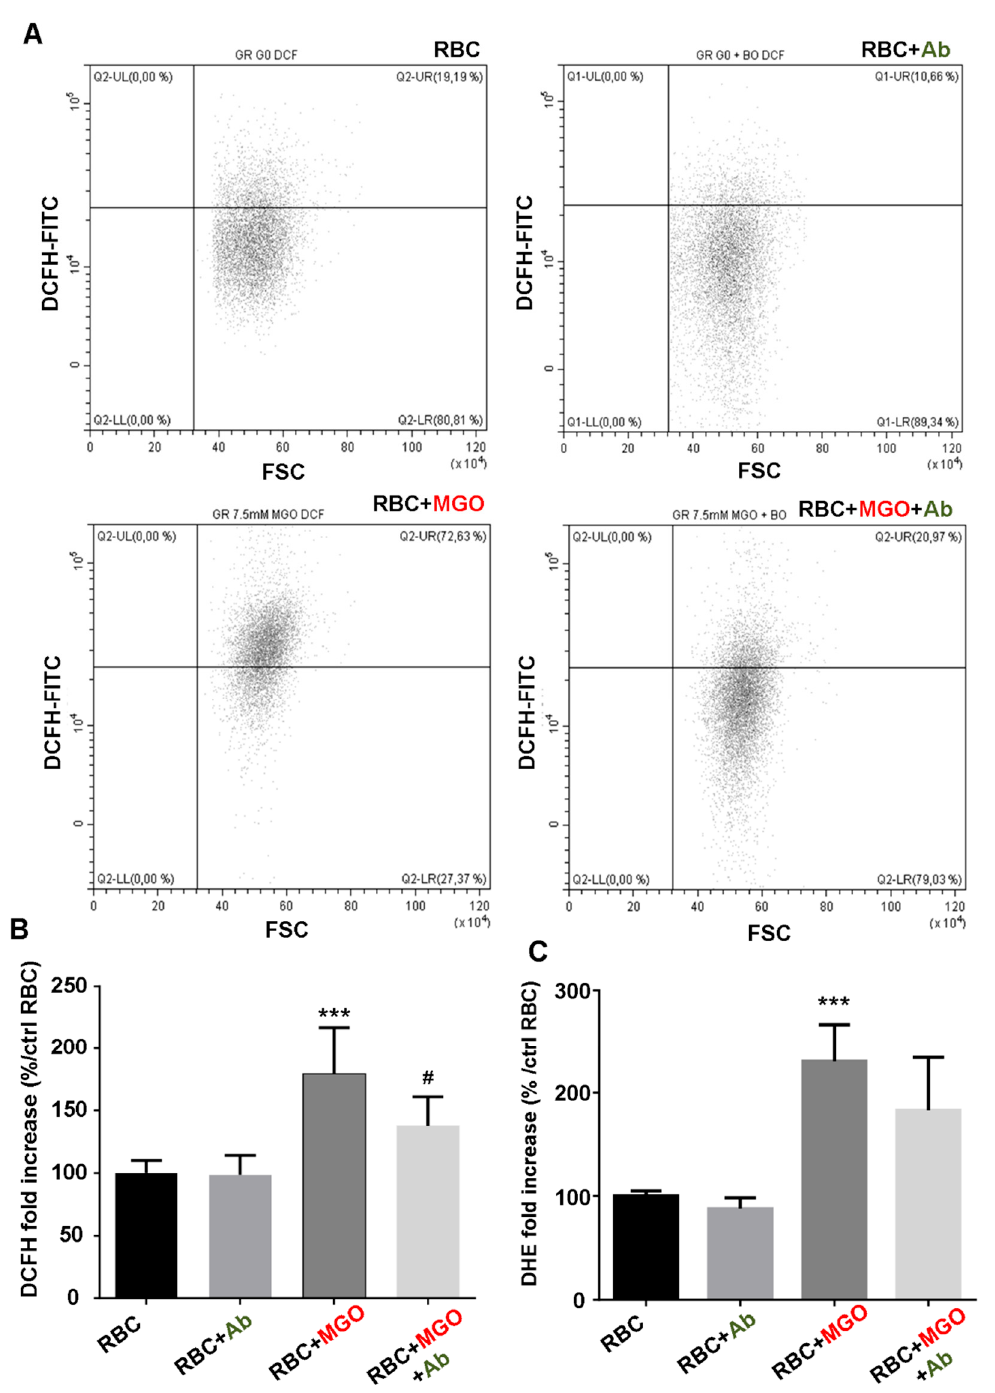
Figure 3. Antioxidant effect of Antirhea borbonica on MGO-induced erythrocyte glycation. Intracellular ROS levels in mature erythrocytes were measured by flow cytometry using DCFH-DA and DHE fluorescent probes. ( A ) Typical FACS dot plots after DCFH staining of RBC; RBC + Ab (in green color); RBC + MGO (in red color) and RBC + MGO + Ab erythrocytes. ( B ) Average fold increase in DCFH fluorescence compared with RBC. Data are mean ± SEM of six independent experiments. *Effect of MGO (vs. RBC), *** p < 0.001. # Effect of Ab (vs. RBC + MGO), # p < 0.05. ( C ) Average fold increase in DCF fluorescence compared with RBC. Data are mean ± SEM of four independent experiments. *Effect of MGO (vs. RBC), *** p < 0.001.